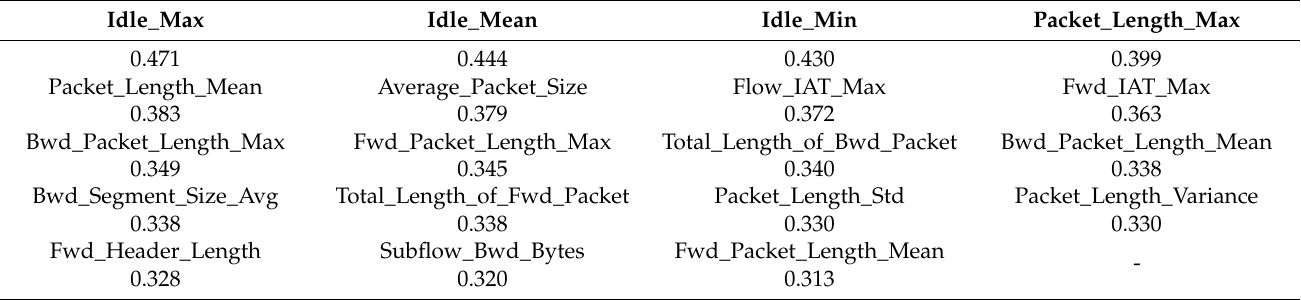
Table 6. Predictive power score.